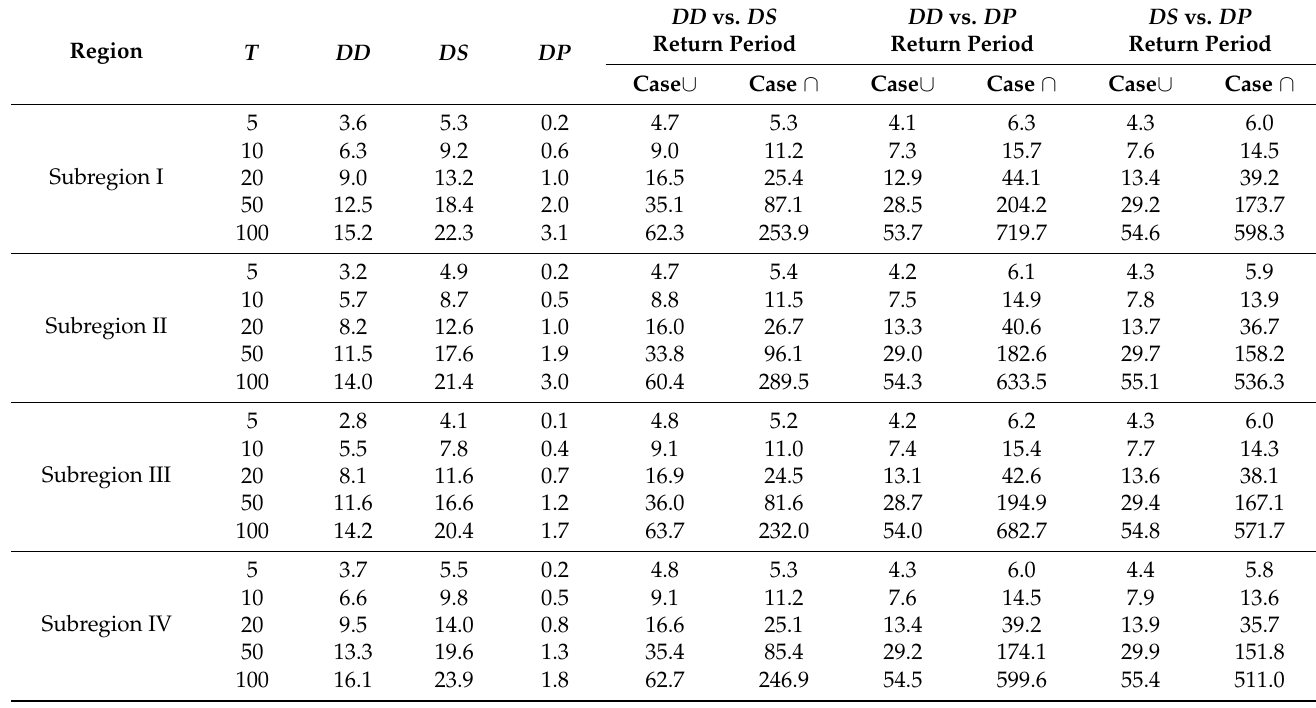
Figure 15. Bivariate return periods of DD vs. DS , DD vs. DP and DS vs. DP : (a) “ ∪ ” return period; (b) “ ∩ ” return period. DD : Drought duration; DS : Drought severity; DP : Drought peak. Table 3. The bivariate return period (years) of DD vs. DS , DD vs. DP and DS vs.